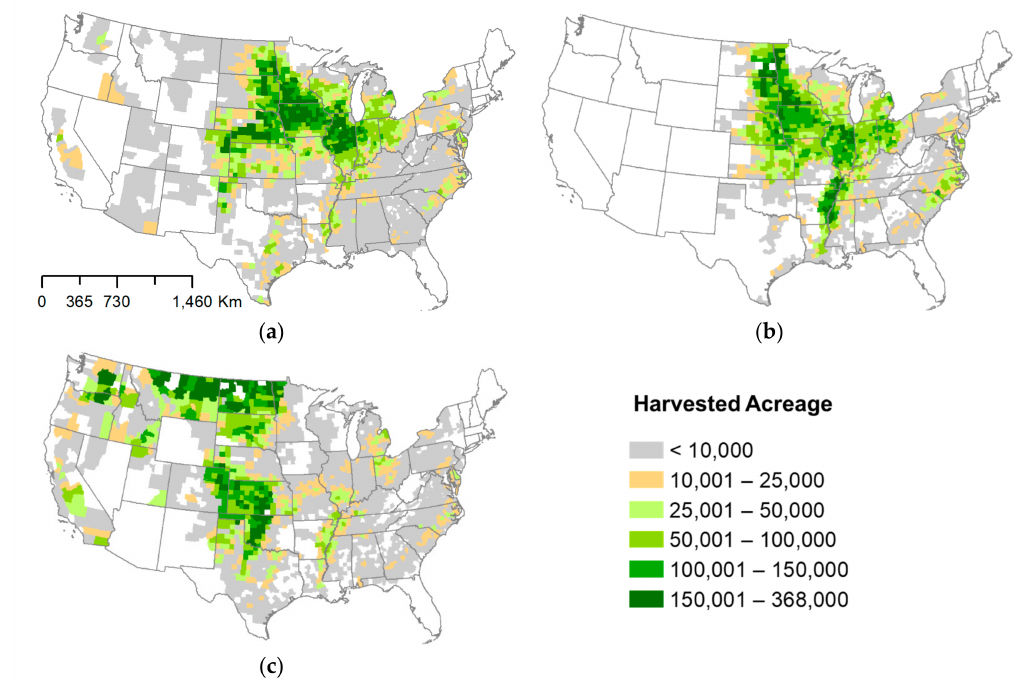
Figure 3. County-level harvested acreages for ( a ) corn, ( b ) soybean, and ( c ) wheat in the conterminous United States in 2008. Data is from U.S. Department of Agriculture (USDA) National Agricultural Statistics Service (NASS) reports